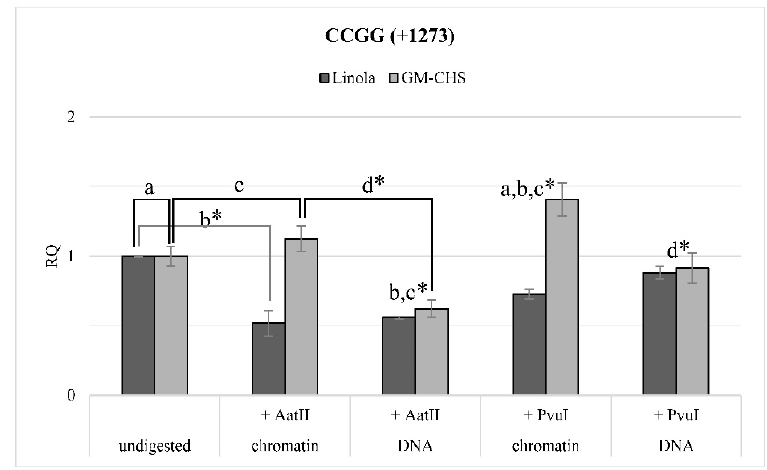
Figure 5. Chromatin/DNA accessibility assay. Chromatin from non-transgenic (Linola) and GM-CHS flax (W92.40) was isolated using a dedicated technical kit. The chromatin and chromatin-derived DNA (primarily treated with proteinase) were incubated with restriction enzymes AatII and PvuI (particular sites for digestion were localized in the CHS gene). After being cut, the DNA was purified and the effect of DNA digestion was assessed by real-time PCR at the methylation CCGG site (+1273). The values are referred to the reference gene expression actin. The relative quantity (RQ) presents the transcript level in comparison to the samples not incubated with the restriction enzymes (undigested,